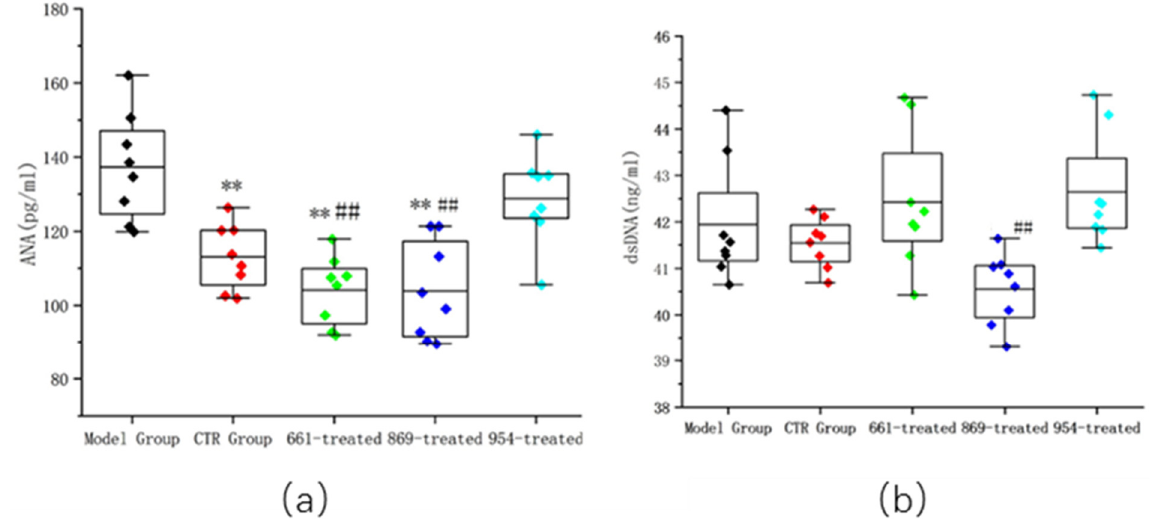
Figure 3. ANA and anti-dsDNA antibody titers. ( a ) Serum levels of ANA in serum; ( b ) serum levels of anti-dsDNA titer in serum. **: Compared with the model group, p < 0.01; ##: compared with the 954-treated group, p < 0.01.